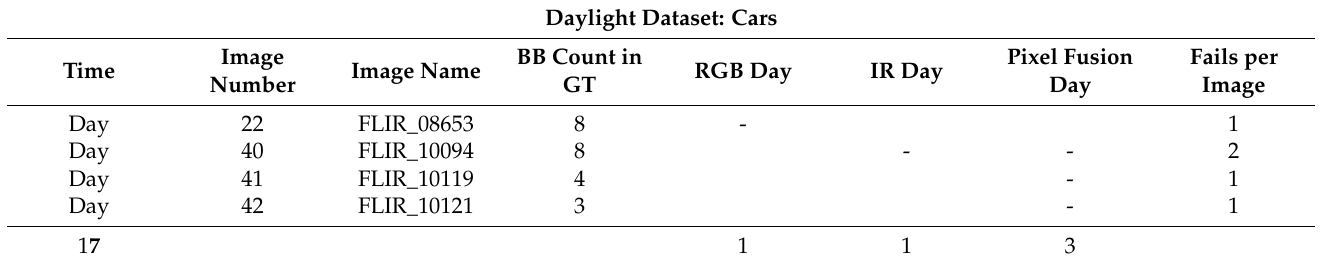
Table A3. Networks trained with daylight image datasets failed to classify 1–3 images for car objects, out of 17 day images.